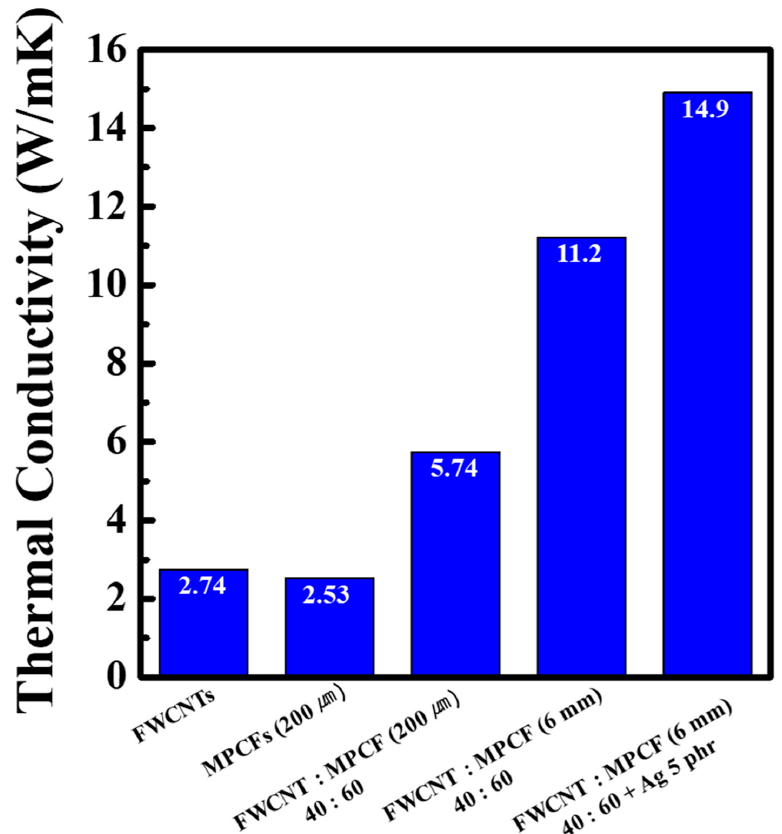
Figure 9. Thermal conductivity of epoxy-based composites containing only FWCNTs, only MPCFs (200 µ m length), FWCNT-MPCF hybrids (MPCF length of 200 µ m or 6 mm; FWCNT:MPCF weight ratio of 40:60), and MWCNT-MPCF-Ag hybrids (MPCF length of 6 mm; FWCNT:MPCF weight ratio of 40:60; Ag content: 5 phr). The total loading amounts of MWCNTs and MPCFs in the epoxy-based composites were adjusted to 10 wt %.